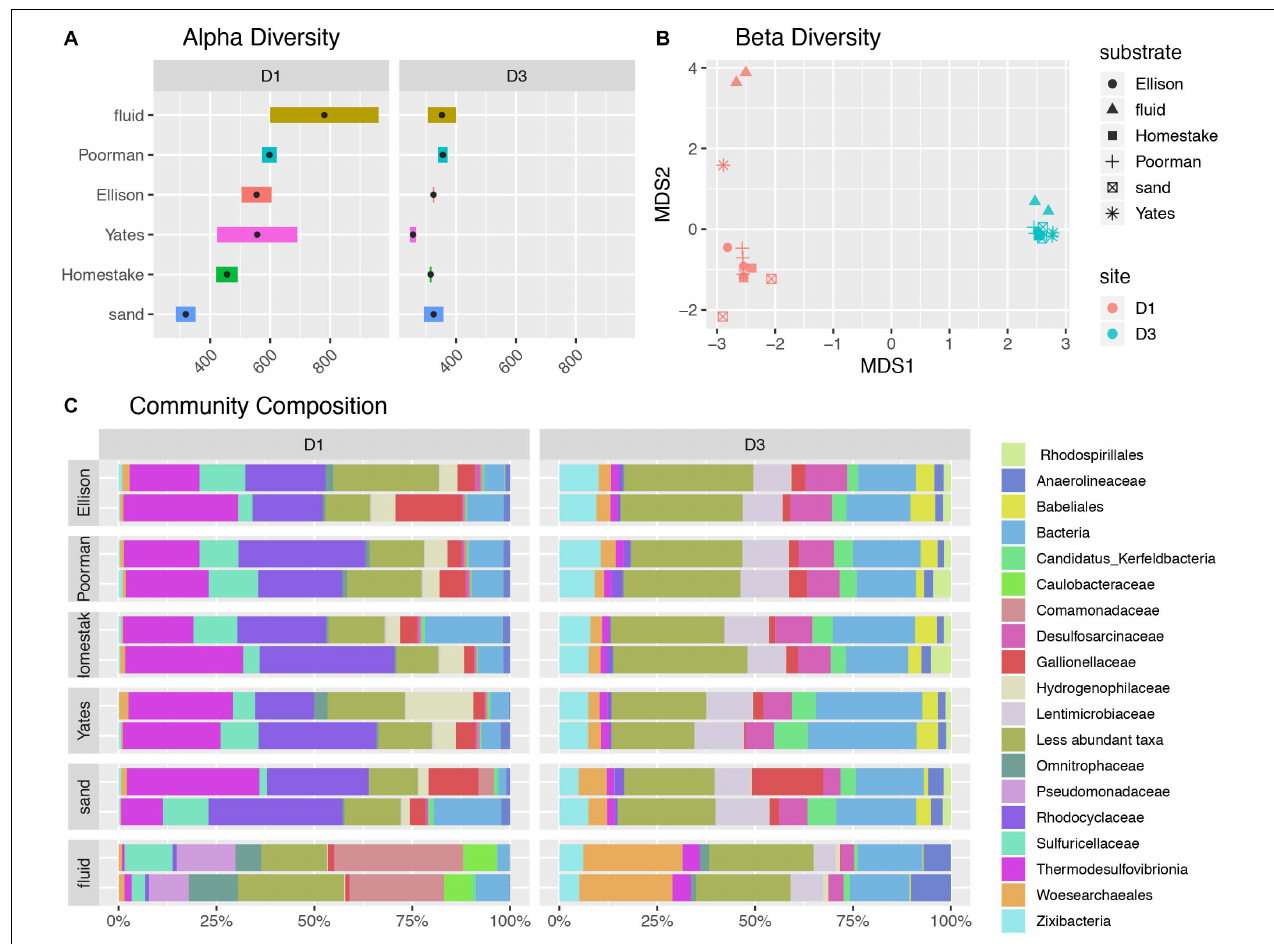
FIGURE 2 | Diversity of communities at DeMMO. (A) Alpha diversity as the number of observed ASVs at a sequencing depth of 46,500 reads. Black points represent mean observed ASV values. (B) Beta diversity as NMDS ordination of ASVs. (C) Community composition as taxa identified to the family level for biofilms in duplicated reactor experiments sampled in December 2019 and fracture fluids sampled in June and December 2019. Less abundant taxa are those representing less than 5% of communities.